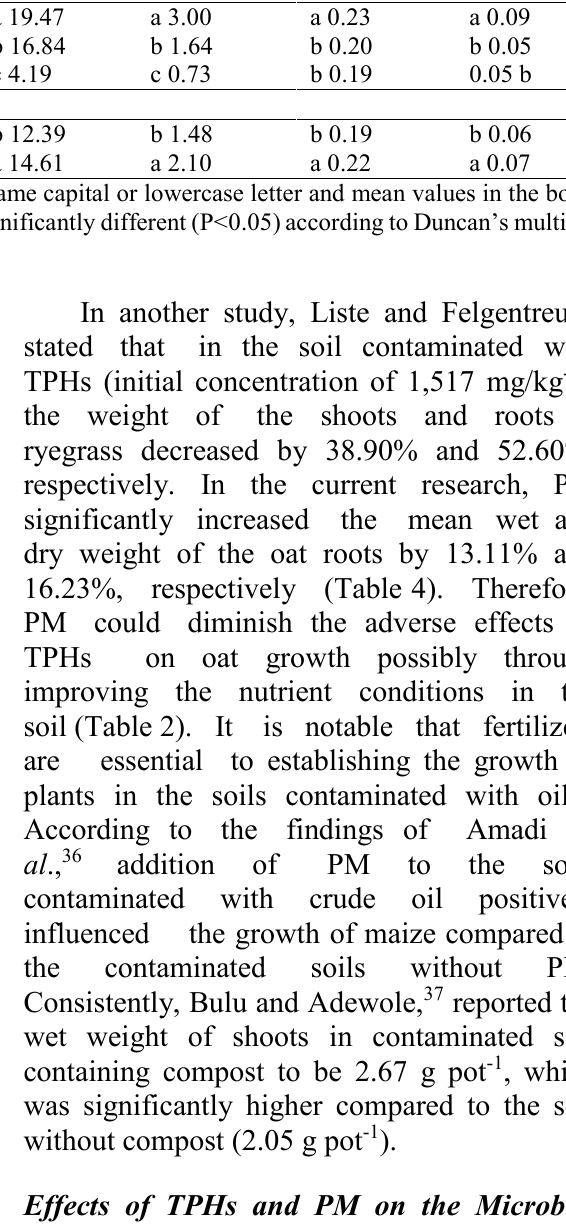
Shoot wet Shoot dry Root wet Root dry weight weight weight weight (gr/pot) (gr/pot) (gr/pot) (gr/pot)